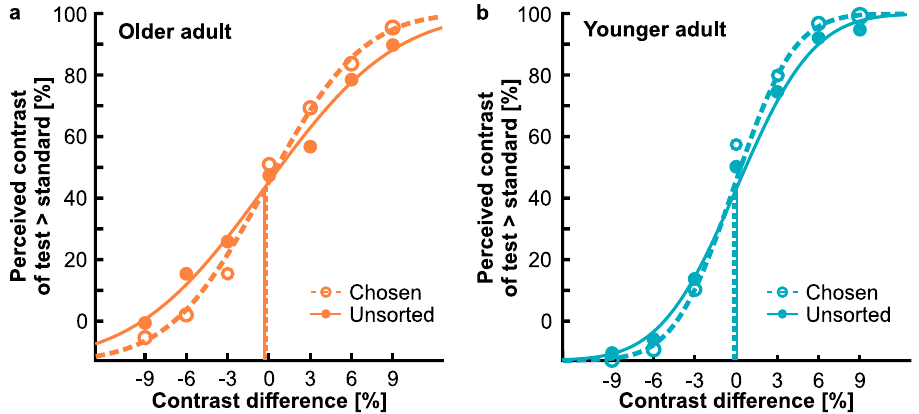
Figure 4. Psychometric functions of contrast discrimination for ( a ) an example older adult and ( b ) an example younger adult. Proportion of decisions indicating higher contrast of the test patch compared to the standard patch is plotted as function of stimulus intensity given as the contrast difference between the test patch and the standard patch. Dashed lines and open dots represent data from the chosen confidence set, solid lines and closed dots represent data from the unsorted confidence set.